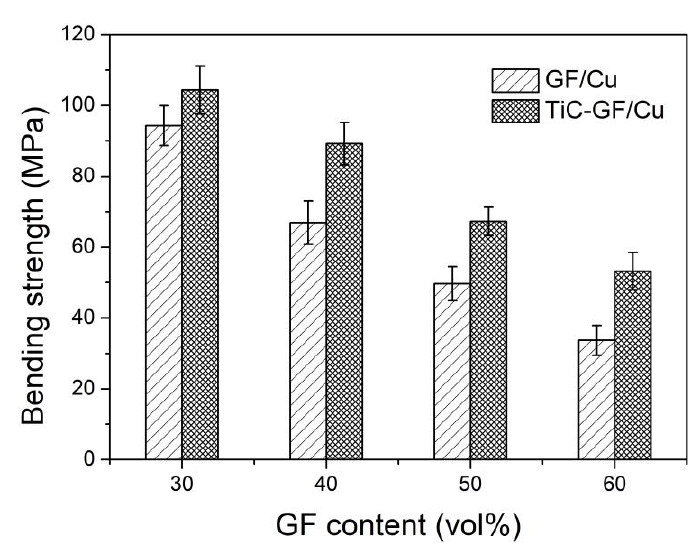
Figure 10. The X - Y plane bending strength of the graphite flake/Cu and TiC-coated graphite flake/Cu composite.